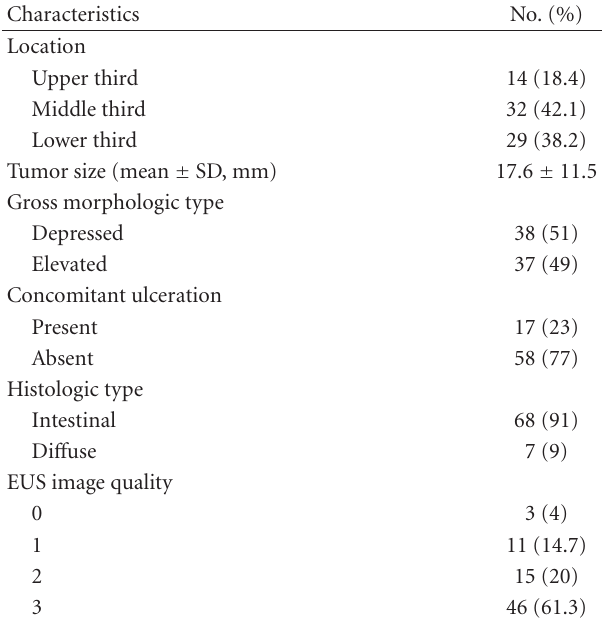
Table 1: Characteristics of the included lesions. Table 2: Comparison of EUS and pathologic staging.